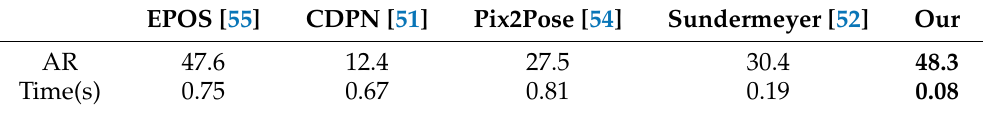
Table 4. Quantitative Evaluation on the T-LESS